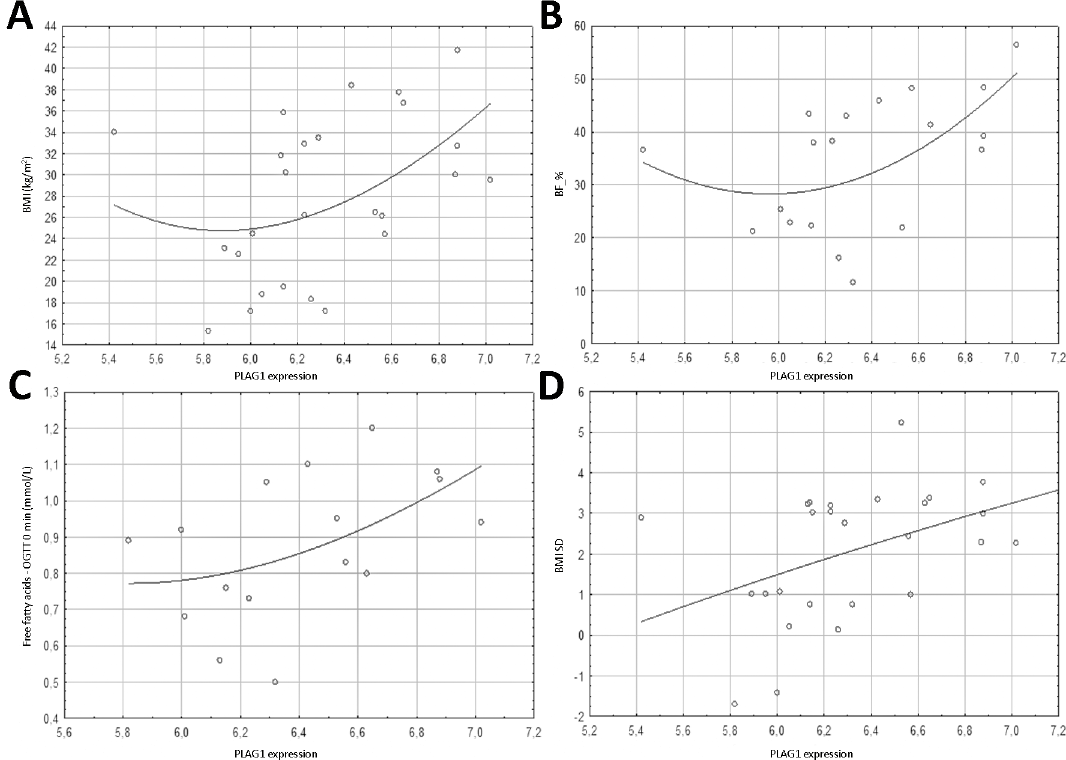
Figure 3. Plots presenting the distribution of data of the studied parameters depending of the level on PLAG1 expression (shown as log 2 of the absolute value of the expression for clarity of the plot). ( A ) BMI (kg/m 2 ); ( B ) BF_%; ( C ) free fatty acids—OGTT 0 min (mmol/L); ( D ) BMI SD.